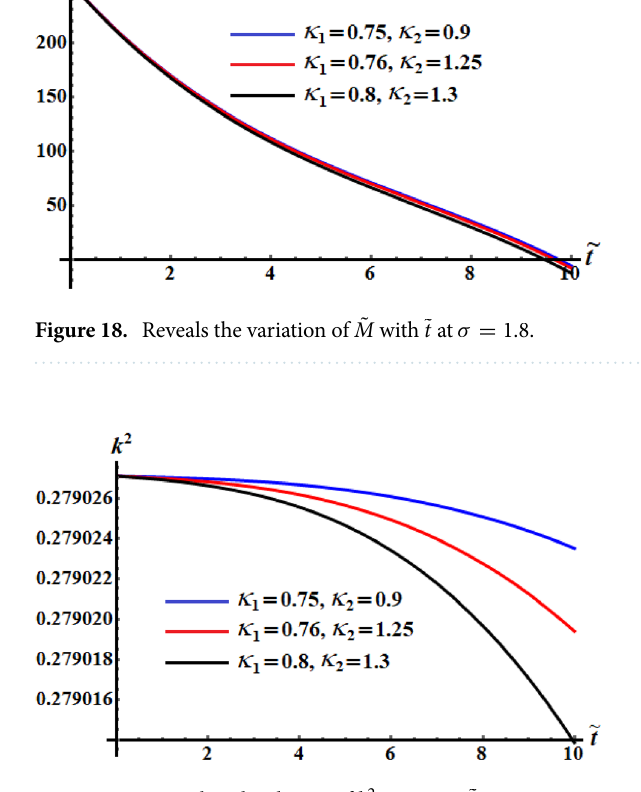
Figure 19. Describes the change of k 2 over time ˜ t at σ = 1.8.